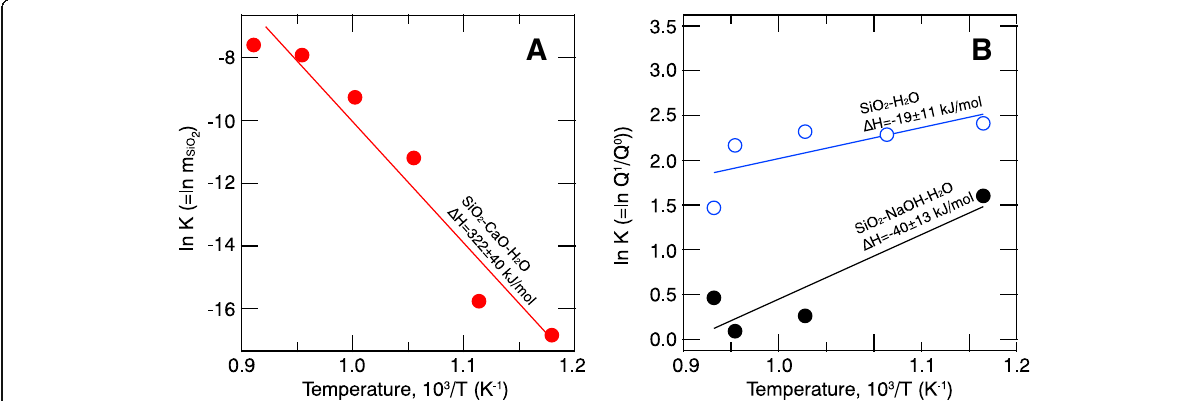
Fig. 8 Equilibrium constants for reactions (4) ( a ) and (2) ( b ) as a function of temperature. The Δ H values are from least squares fit to Eq.